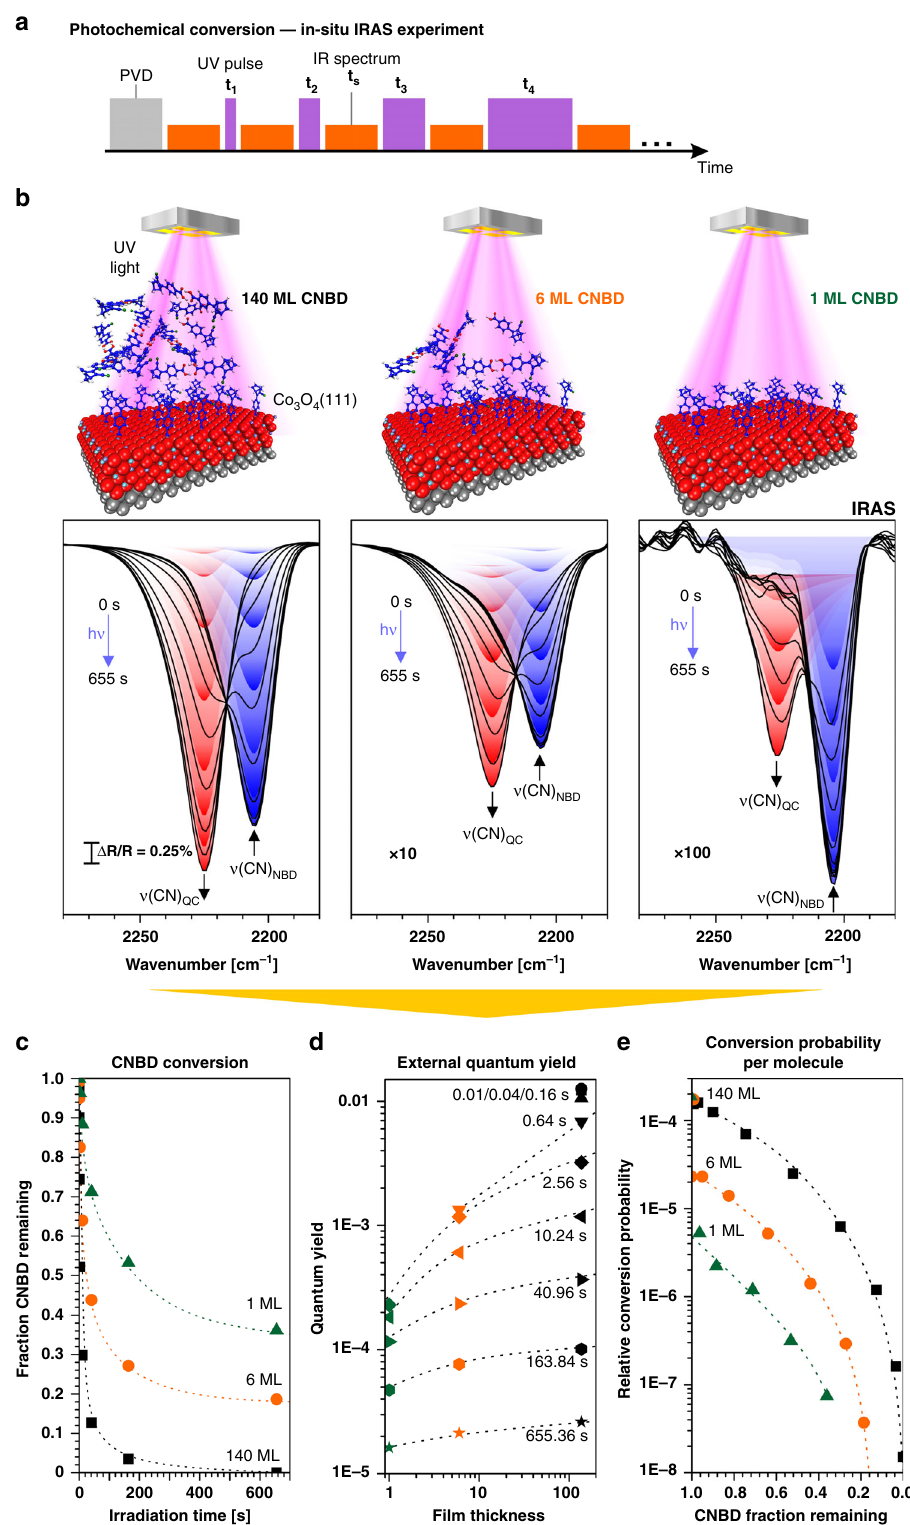
Fig. 3 Photochemical conversion of CNBD fi lms on an ordered Co 3 O 4 (111) surface: a the experimental procedure used in the photochemical IRAS experiment; b spectral region of the CN stretching bands of CNBD and CQC during UV irradiation for a thick multilayer fi lm (140 ML), a thin multilayer fi lm (6 ML), and an anchored monolayer fi lm (1 ML). All spectra were referenced to the clean sample; c the fraction of residual CNBD as a function of irradiation time (green triangles: 1 ML, orange circles: 6 ML, black squares: 140 ML); d external quantum ef fi ciency as a function of fi lm thickness and irradiation time (circles: 0.01 s, squares: 0.04 s, triangles (top): 0.16 s, triangles (bottom): 0.64 s, diamonds: 2.56 s, triangles (left): 10.24 s, triangles (right): 40.96 s, hexagons: 163.84 s, stars: 655.36 s); e photoconversion probability per molecule as a function of conversion and fi lm thickness (green triangles: 1 ML, orange circles: 6 ML, black squares: 140 ML